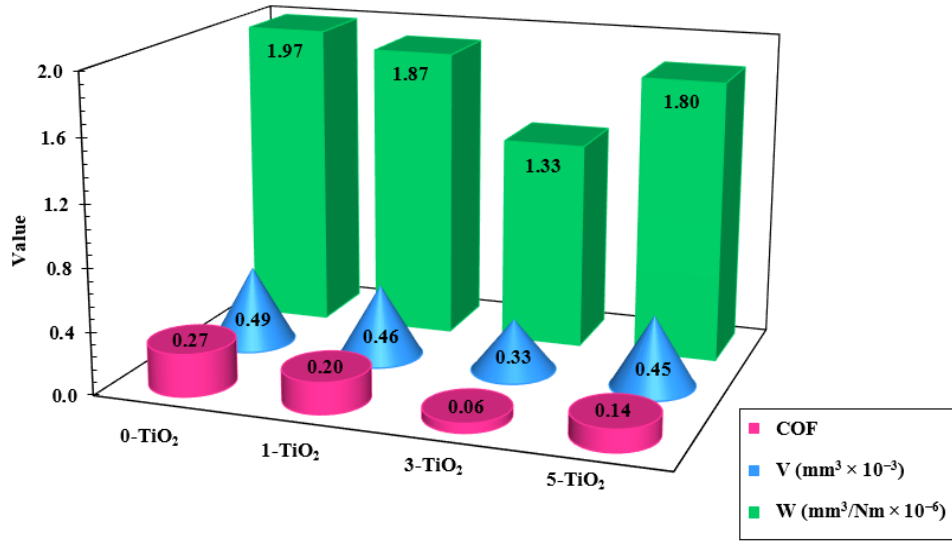
Figure 5. The variations of COF, V, and W values for four different coated